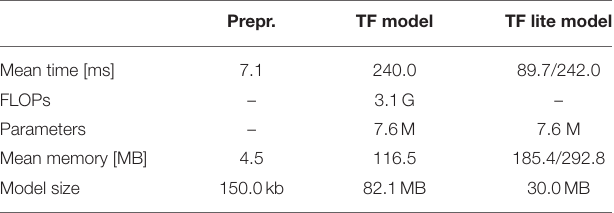
TABLE 5 | This table shows the mean execution time, the number of parameters, the mean requested memory, and the model size of our preprocessing (prepr.), the DenseNet121 TensorFlow (TF), and TF Lite